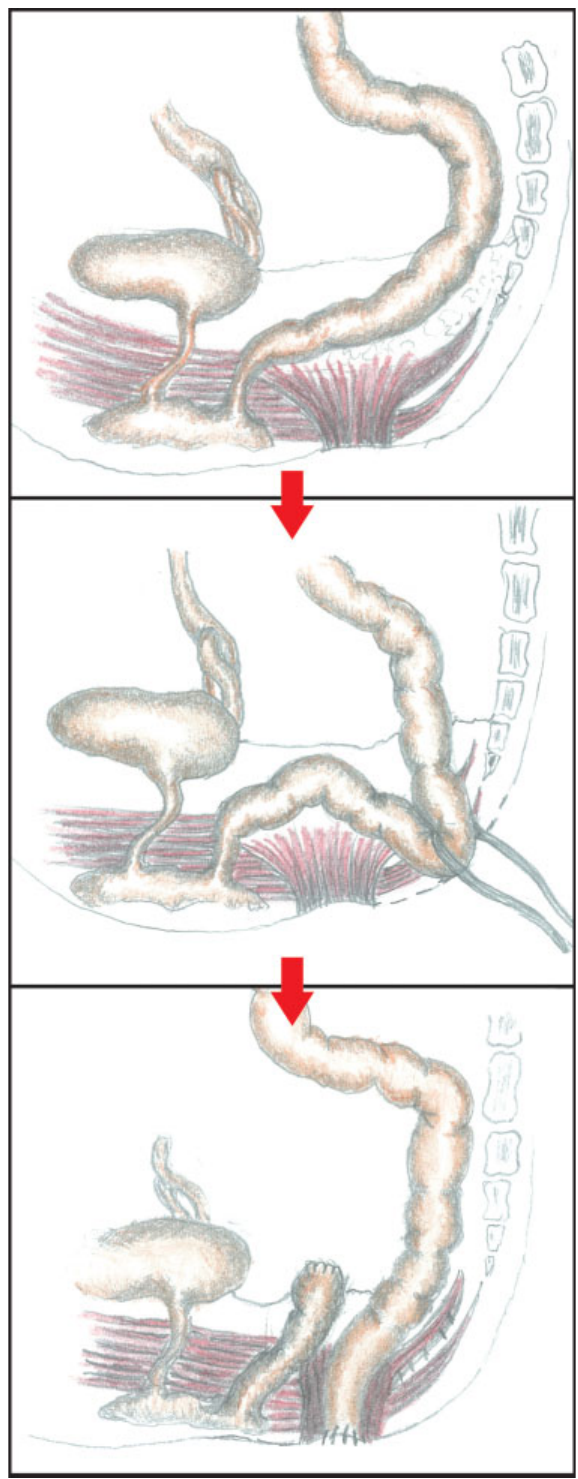
Fig. 9 Sketch of the one-stage posterosagittal approach, preserving the muscular sphincter complex (Liem and Hau, and Liem and Quynh technique), to correct vaginal agenesis and anorectal malformation with rectovestibular fi